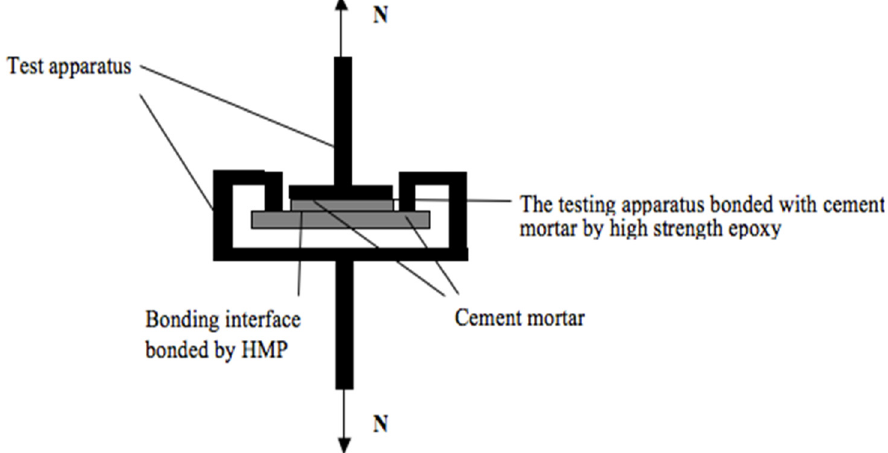
Figure 2. A sketch map of apparatus for bonding